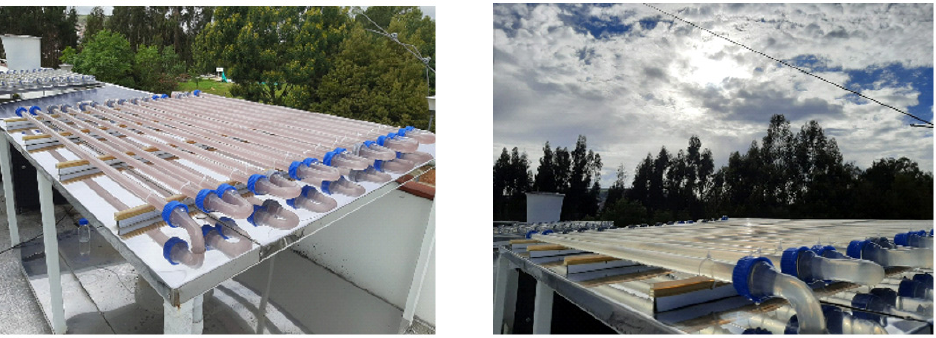
Figure 3. Sunlight reactor images before ( left ) and after ( right ) UV/H 2 O 2